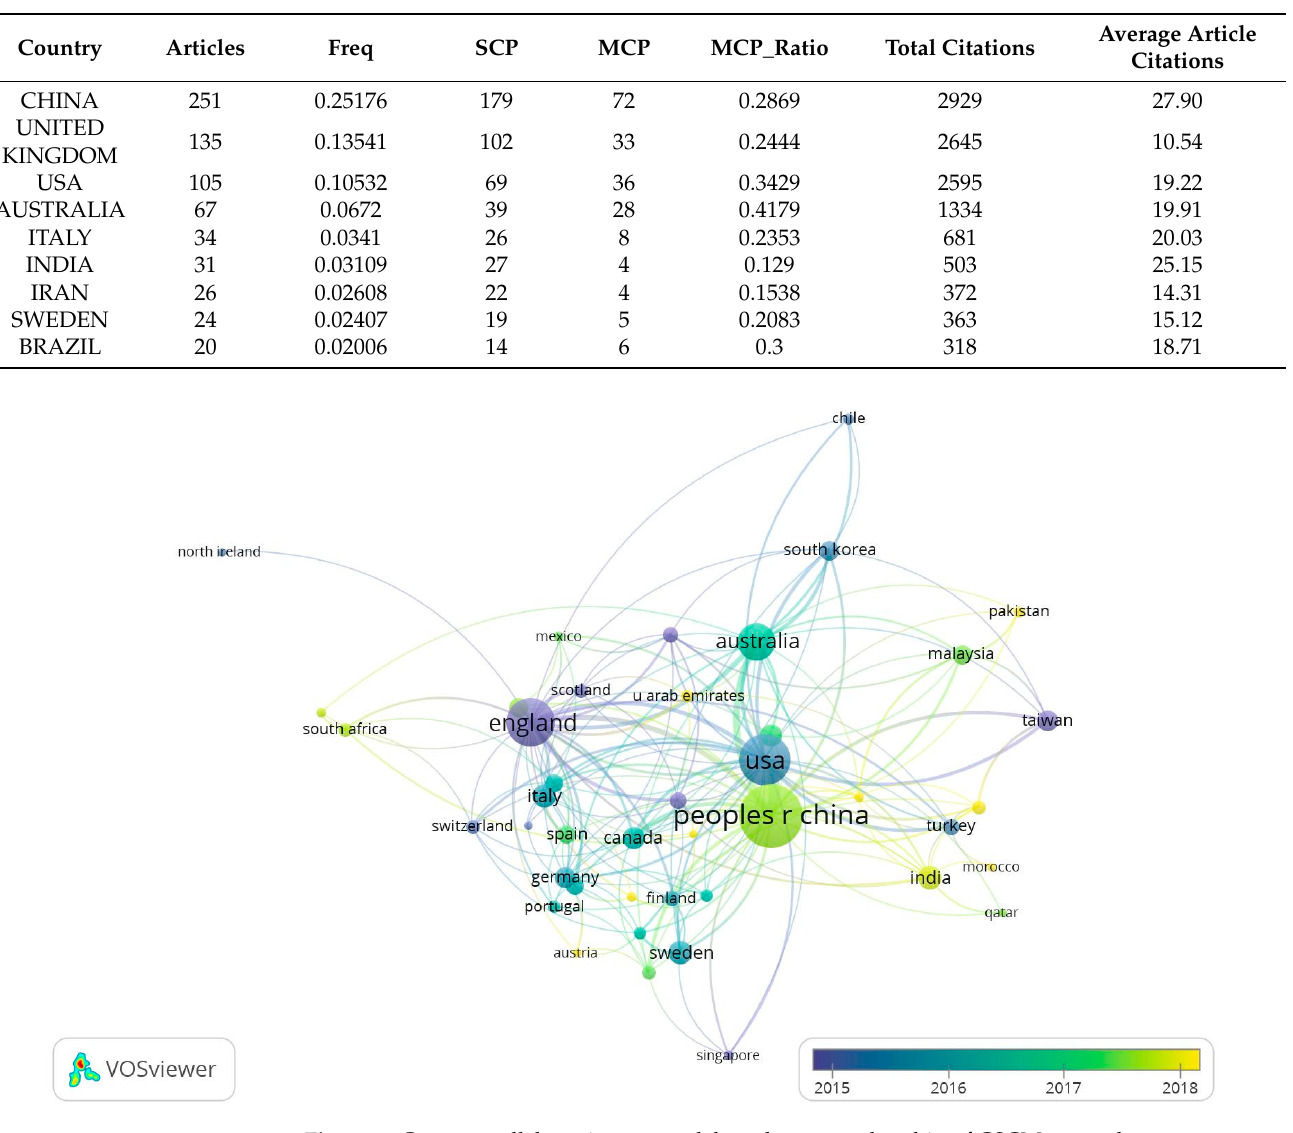
Figure 5. Country collaboration network based on co-authorship of CSCM research .